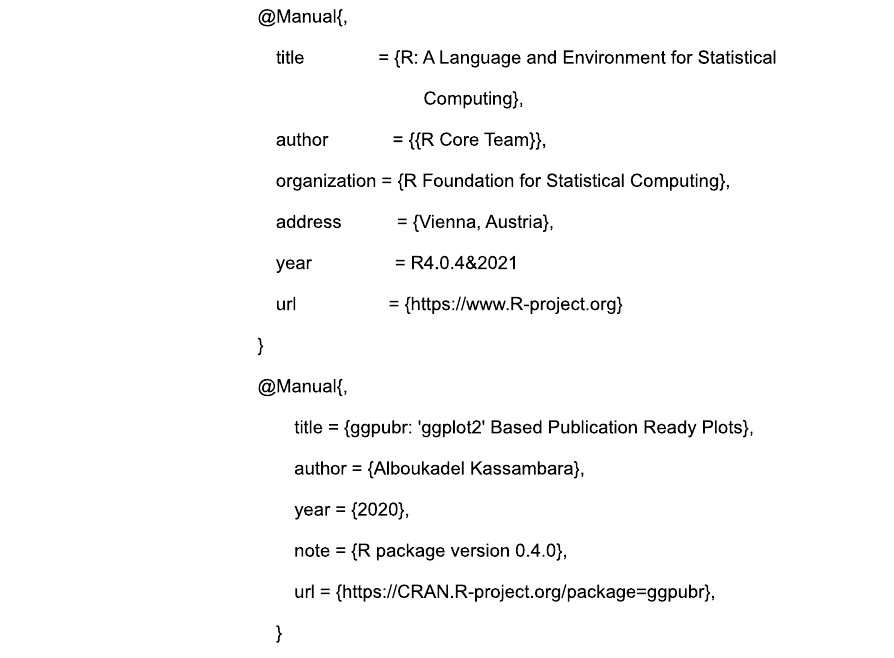
Figure 5. Relationship between SCD5 expression and response to neoadjuvant chemotherapy. ( A ) SCD5 expression in pCR cohort (patients with pathological complete response to neoadjuvant chemotherapy) and RD cohort (patients with residual disease after neoadjuvant chemotherapy) using datasets from GEO. ROC curves for SCD5 expression levels to discriminate the breast cancer patients (especially TNBC patients) who achieve pCR from non-pCR after neoadjuvant chemotherapy using data from GEO datasets. ( B ) The DEGs of GSE25055 dataset (TNBC samples) were shown as cluster heatmaps. The DEGs were generated from pCR-group and RD-group. The red points represented upregulated genes (logFC > 1), while the blue points represented down-regulated genes (|log fold change (FC)|> 1, p <